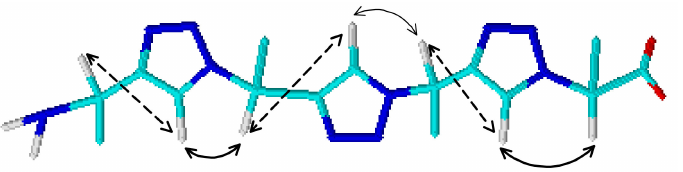
Figure 8. Predominant zig-zag conformation of the triazolamer revealed by the ROESY experiments. The solid and dashed lines indicate strong and weak NOE correlations, respectively. Atom colors: light blue for carbon, dark blue for nitrogen, and red for